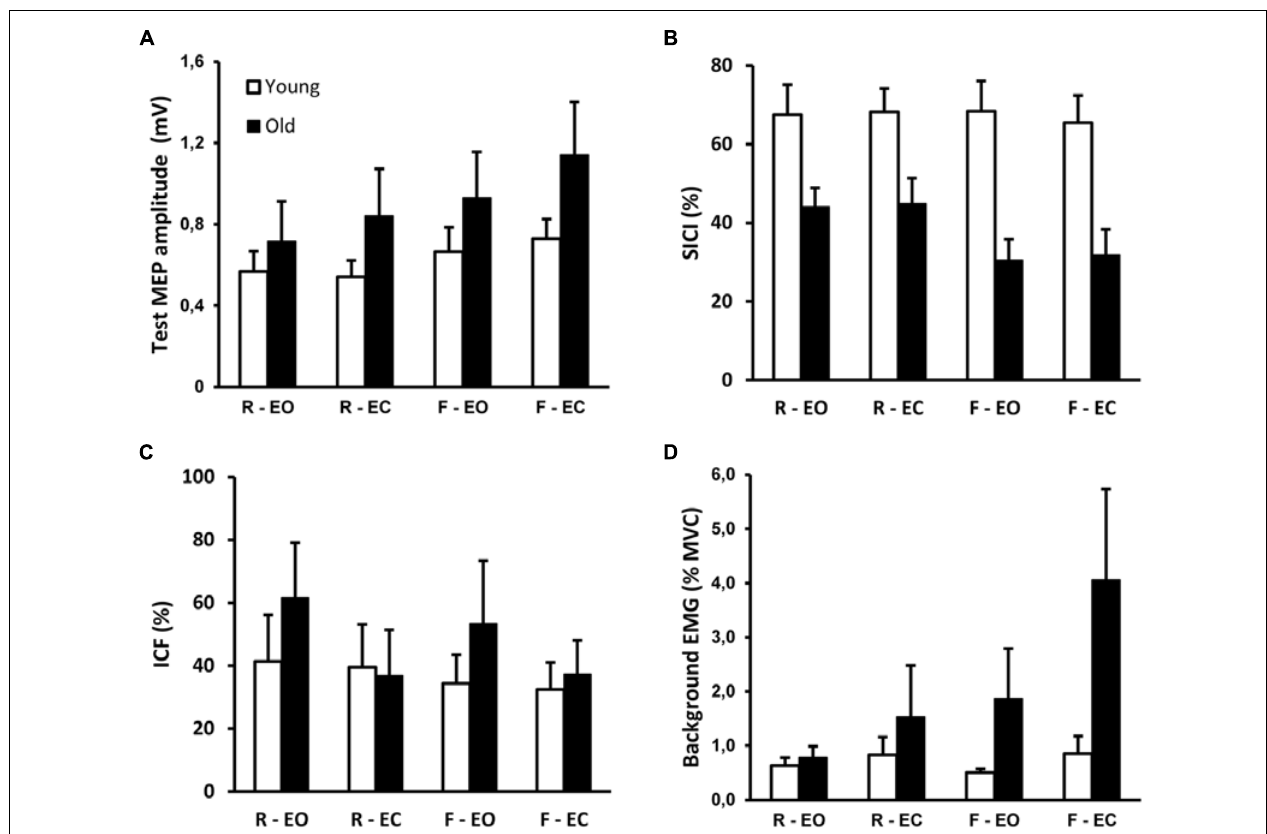
FIGURE 3 | Group data (mean ± SE) for young and old adults of (A) amplitude test MEP (condition effect, p < 0.001), (B) short interval intracortical inhibition (SICI; group effect, p = 0.001; interaction effect, p = 0.049), (C) intracortical facilitation (ICF),